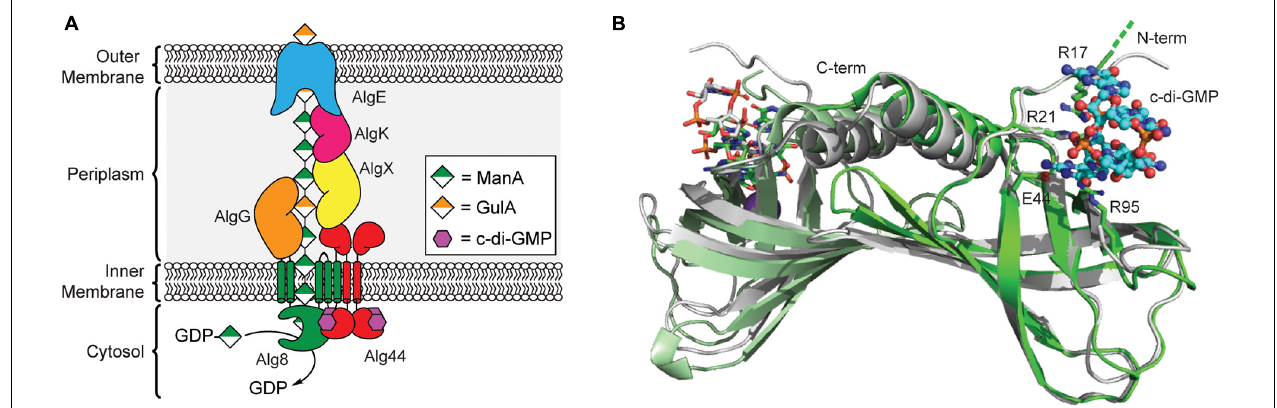
FIGURE 3 | Regulation of alginate biosynthesis through the binding of c-di-GMP to Alg44. (A) Organization of the biosynthetic machinery of alginate synthase in P. aeruginosa . (B) Binding of c-di-GMP dimer results in a small conformational change in the PilZ domain of Alg44. Structures of dimeric Alg44 PilZ domain bound to c-di-GMP dimer (green, PDB id 4RT0) or a Alg44 R95A mutant bound to c-di-GMP monomer (white, PDB id